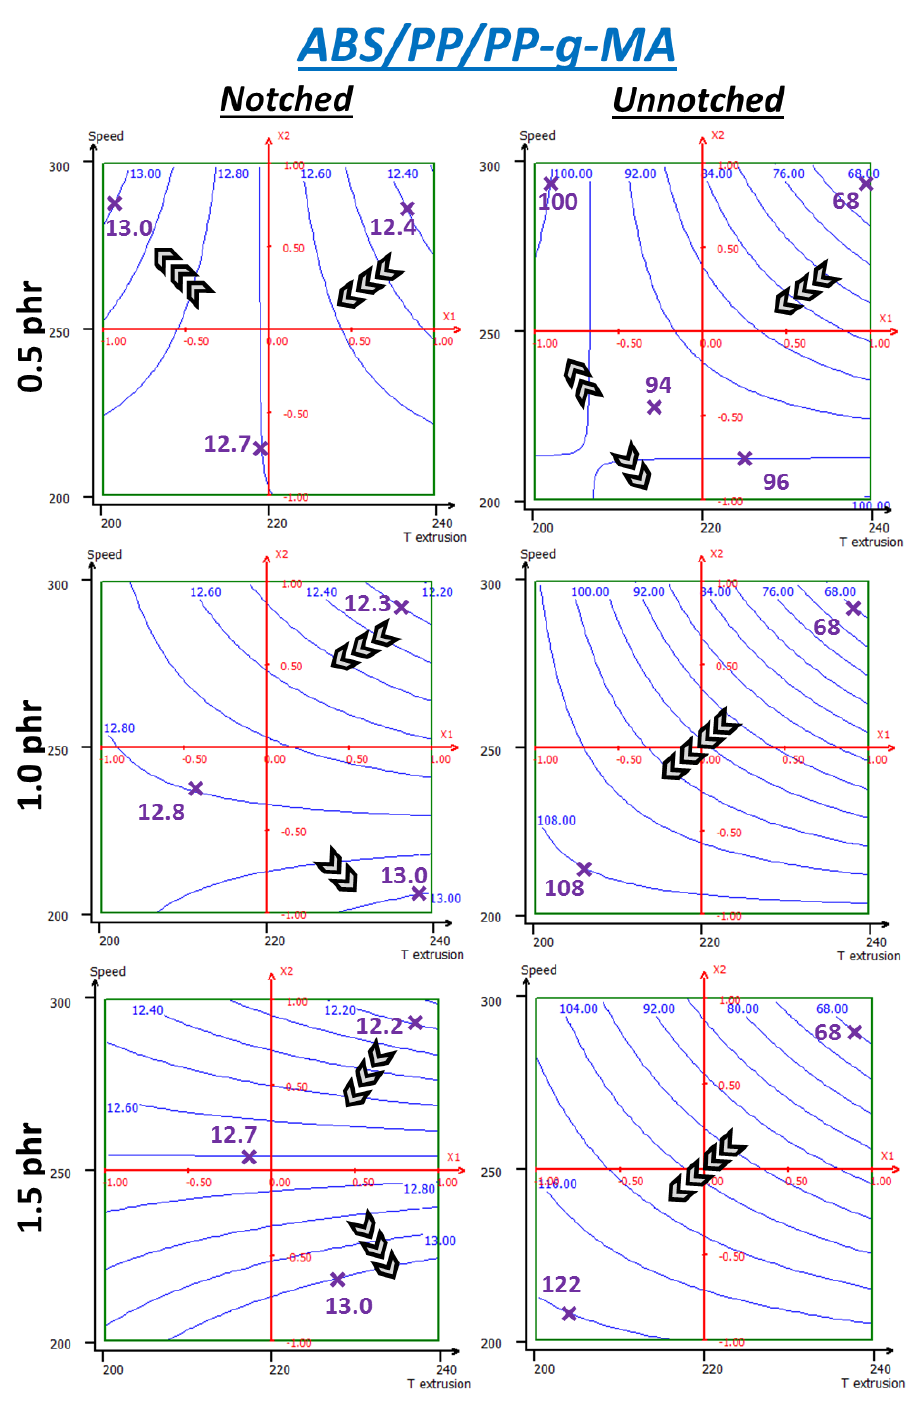
Figure 17. RSM applied to notched and unnotched Charpy break energies (kJ/m2) of ABS + 4wt% PP + PP-g-MA—same variables as those used